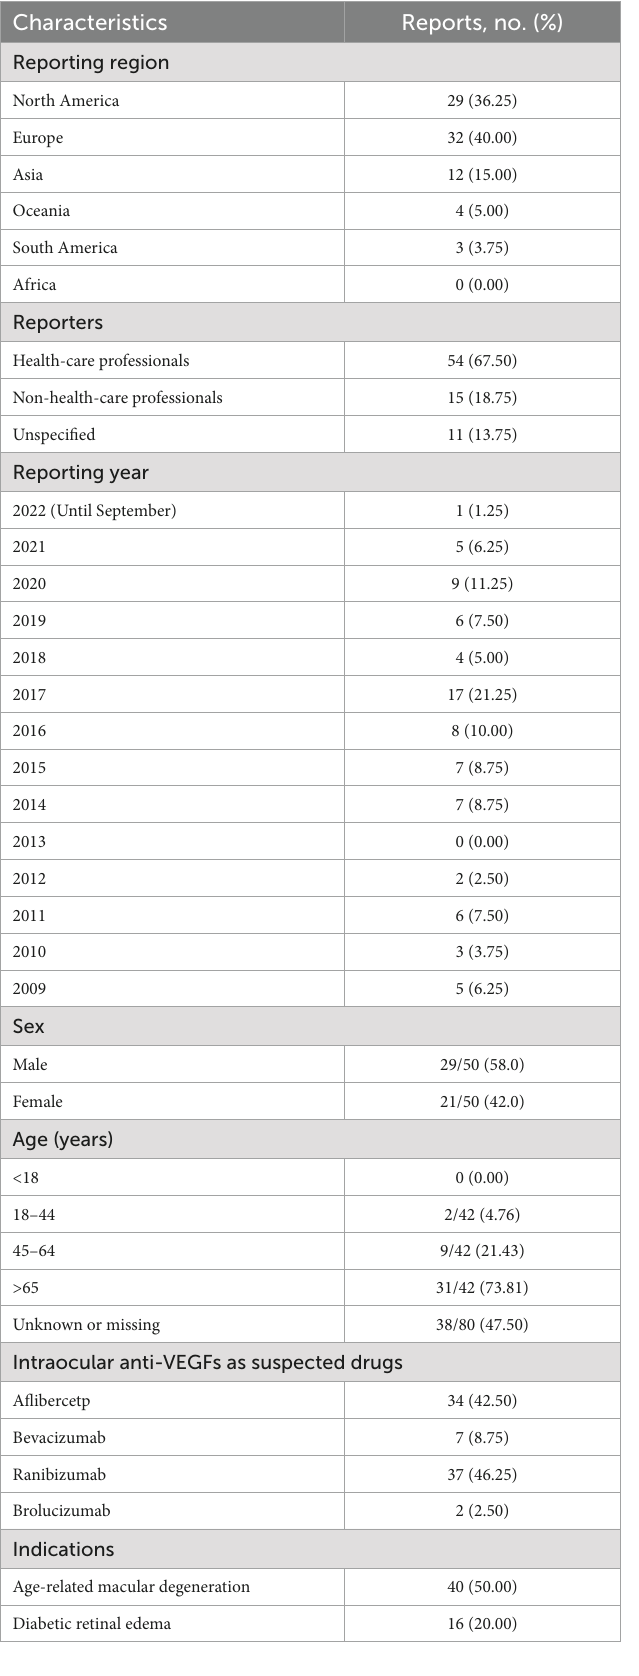
TABLE 2 Clinical characteristics of patients with renal AEs after intraocular administration of anti-VEGFs sourced from the FAERS database (January 2004 to September 2022).